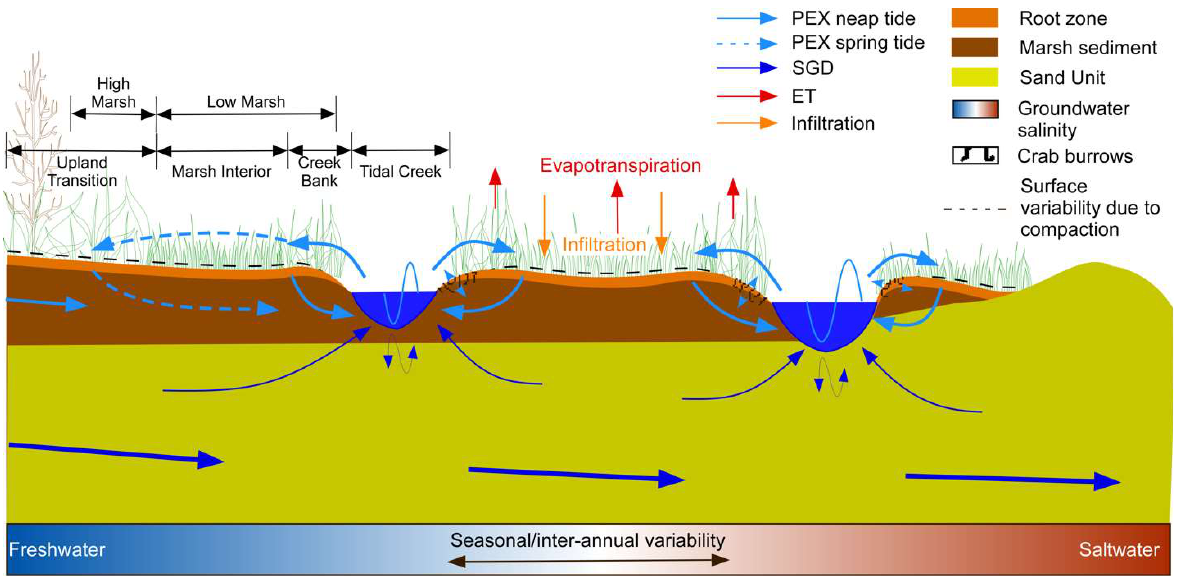
Figure 1. Conceptual diagram of a salt marsh ecosystem from the upland transition to beach environments. Color bar indicates a generalized groundwater salinity gradient across the underlying sand unit. Colored arrows show flow paths of hydrologic components (e.g., PEX, SGD, ET). Sine wave in surface water indicates tidal fluctuations in channels.